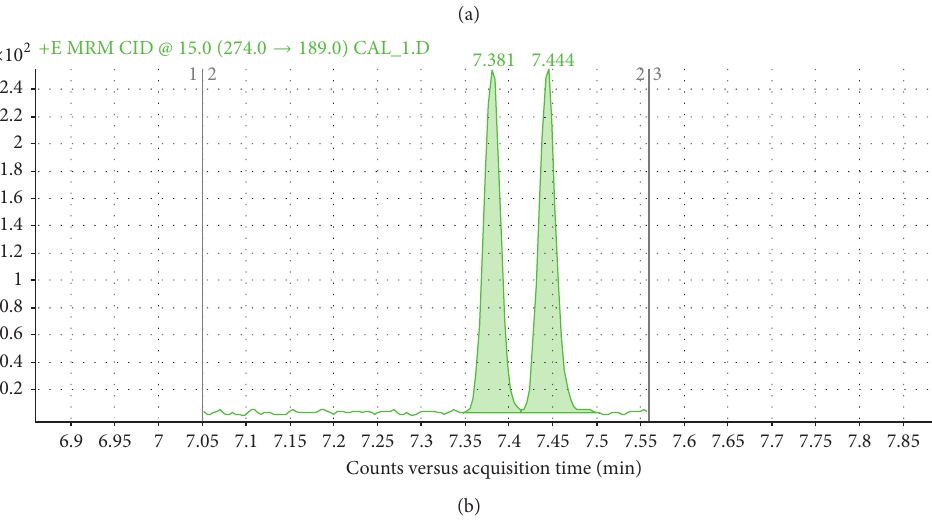
Figure 1: Extracted MRM chromatograms for (a) MDMA-d5 and (b) MDMA at 20 𝜇